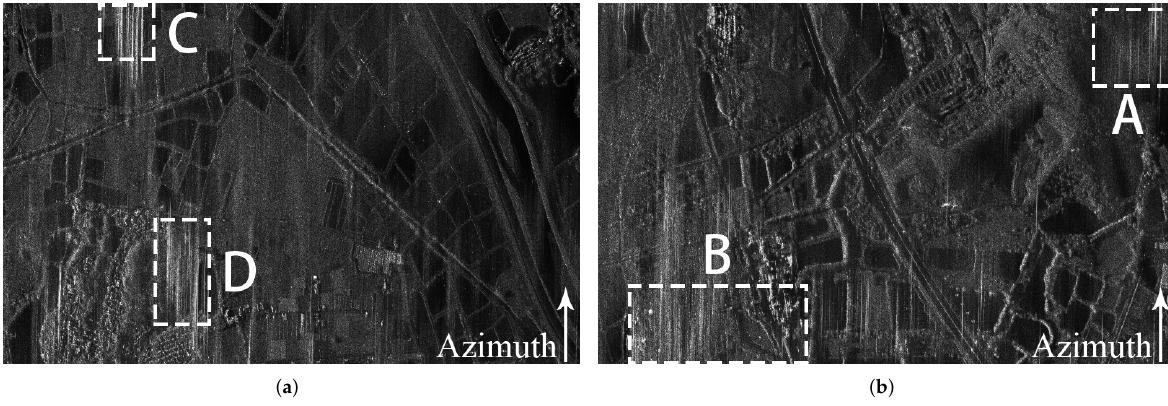
Figure 21. The images of the conventional scheme. ( a ) The near-end sub-swath. ( b ) The far-end sub-swath.